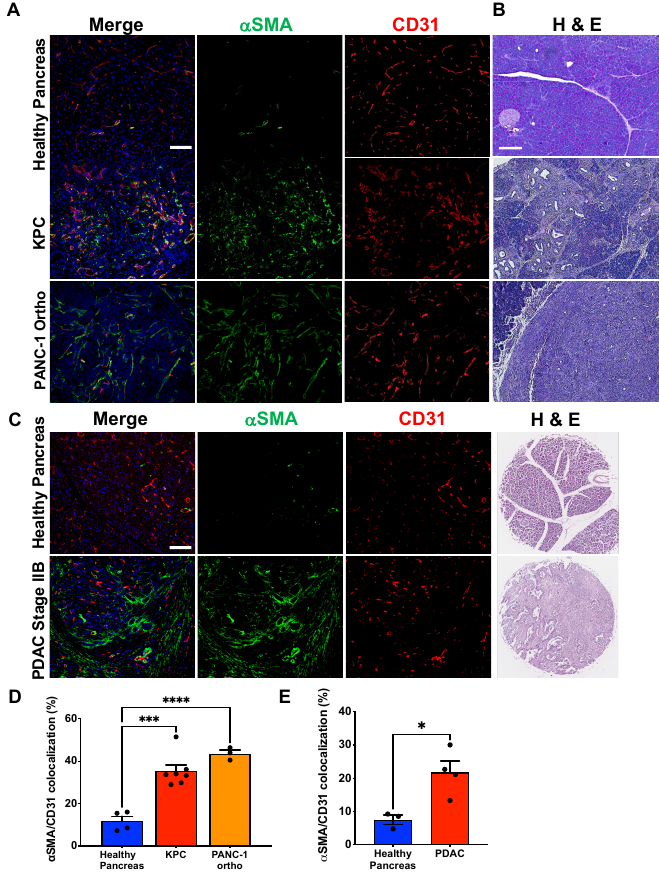
Cancers 2022 , 14 , x Figure 1. PDAC-associated pericytes exhibit aberrant molecular phenotype. ( A ) Representative images of FFPE sections of KPC and PANC-1 tumors, and healthy pancreas tissues immunolabeled for hypoxic area was also observed in PANC-1 orthotopic tumors (Figure S4A,B). In human CD31 and α SMA. Sections are counterstained with DAPI (blue) to visualize nuclei. ( B ) Representative PDAC, both the α SMA + pericyte coverage and CA9 + hypoxic area were significantly images of H&E stained KPC and PANC-1 tumors, and healthy pancreas tissues. Scale bar: 200 µ m. higher in stage-III than stage-I tumors, suggesting progressive deterioration of tumor vas- ( C ) Representative images of FFPE tissue microarray sections from normal human pancreas and PDAC culature over time (Figure S4C). Although the PDAC tumors presented significantly tumors immunolabeled for CD31 and α SMA or H&E-stained. Scale bar: 100 µ m. ( D ) Quantification higher hypoxia, the overall microvascular density (MVD) showed no differences between of percentage of CD31 + vessels associated with α SMA + pericytes (WT n = 4, KPC n = 7 and PANC-1 the healthy pancreas and PDAC tumors, indicating that hypoxia is due to the quality of ortho tumors n = 3). One-way ANOVA with Dunnett’s multiple comparisons was used to determine vessels rather than their quantity (Figure 2E,F). Overall, vascular leakiness, measured by statistical significance. ( E ) Quantification of percentage of CD31 + vessels associated with α SMA + FITC-Dextran, was significantly correlated with tumor hypoxia and α SMA + pericyte cov- pericytes (healthy pancreas n = 3, PDAC n = 4). Unpaired two-tailed t -test was used to determine erage (Figure 2G,H). The α SMA + pericyte coverage was also correlated with tumor hy- poxia (Figure 2I). This result strongly supports our hypothesis that ecto pic α SMA expres- statistical significance. Scale bar: 100 µ m; apply to all images. Unless otherwise stated, the data are sion confers a pathological phenotype to PDAC-associated pericytes. represented as the mean ± SEM. * p < 0.05, ** p < 0.001, *** p < 0.0001.